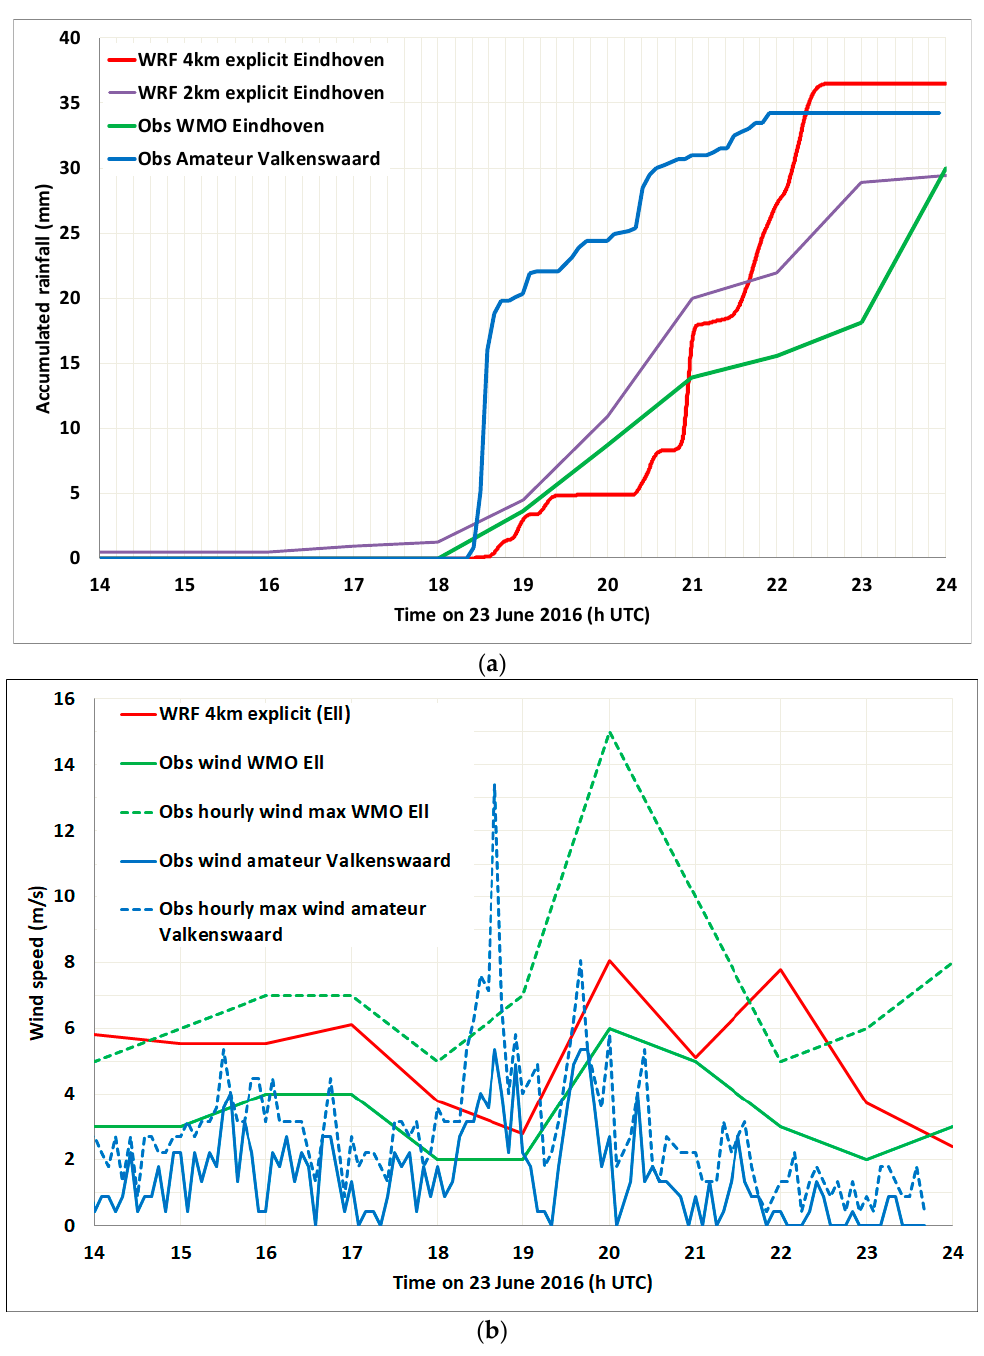
Figure 6. Modelled and observed accumulated rainfall ( a ), wind speed and maximum wind speed ( b ) over southwest Noord-Brabant The Netherlands. Precipitation observations originate from the WMO station Eindhoven and an amateur weather station in Valkenswaard. Wind speed observations originate from the WMO station Ell and an amateur weather station in Valkenswaard.